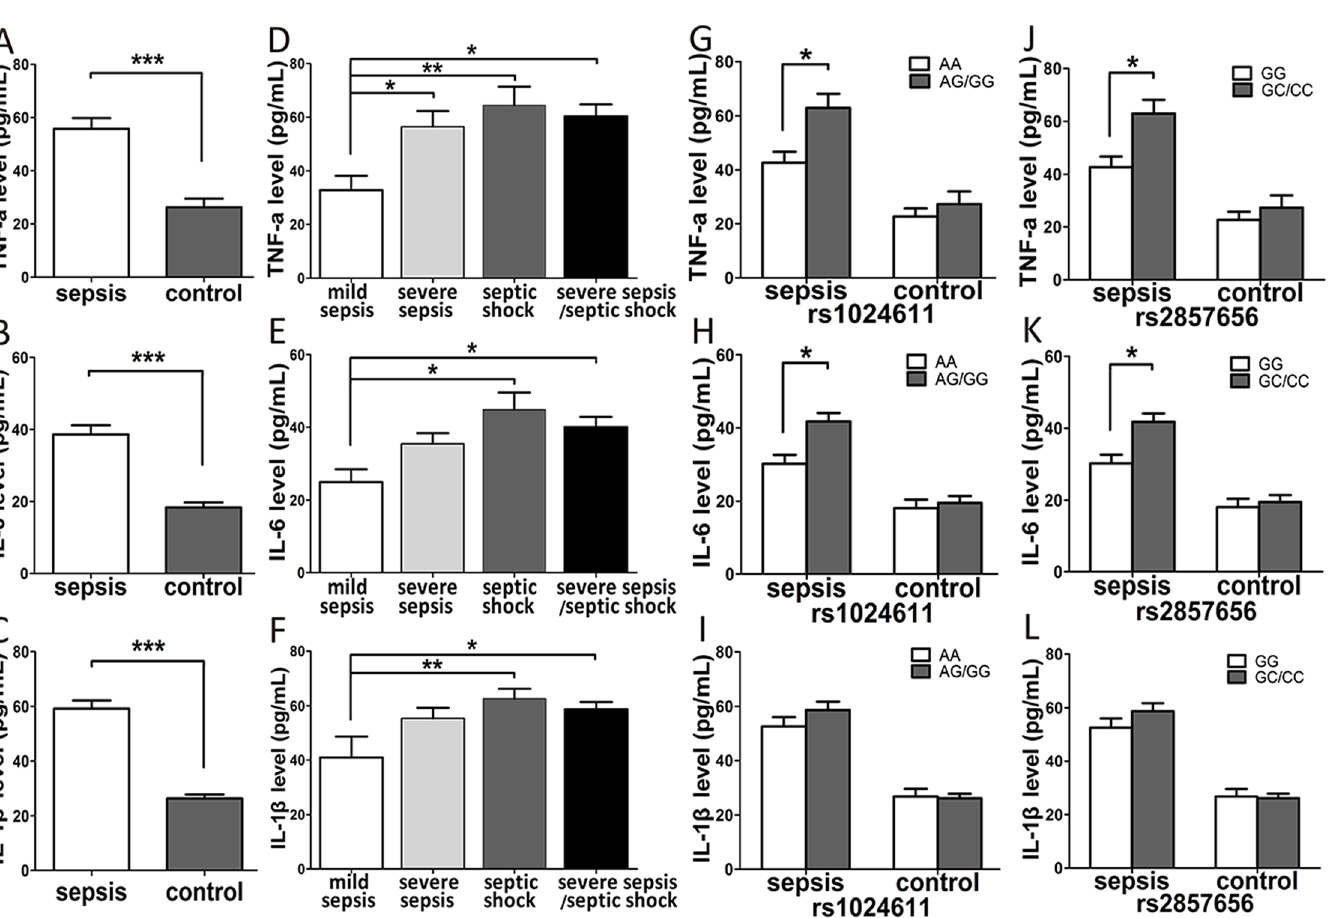
Fig 4. The plasma concentrations of pro-inflammatory cytokines polymorphisms in sepsis patients (n = 80) and healthy controls (n = 80). The plasma concentration of TNF- α (A), IL-6 (B) and IL-1 β (C) in sepsis cases (n = 80) and controls (n = 80), and the plasma concentration of TNF- α (D), IL-6 (E) and IL-1 β (F) in mild sepsis, severe sepsis and septic shock subgroups. The distribution of the plasma concentration of TNF- α (G), IL-6 (H) and IL-1 β (I) in groupsof sepsis patients with different rs1024611genotypes. The distributionof the plasma concentration of TNF- α (J), IL-6 (K) and IL-1 β (L) in groups of sepsis patients with different rs2857656 genotypes. The horizontalline stands for the medianconcentration with each group. * P < 0.05; ** P < 0.01; *** P < 0.001.